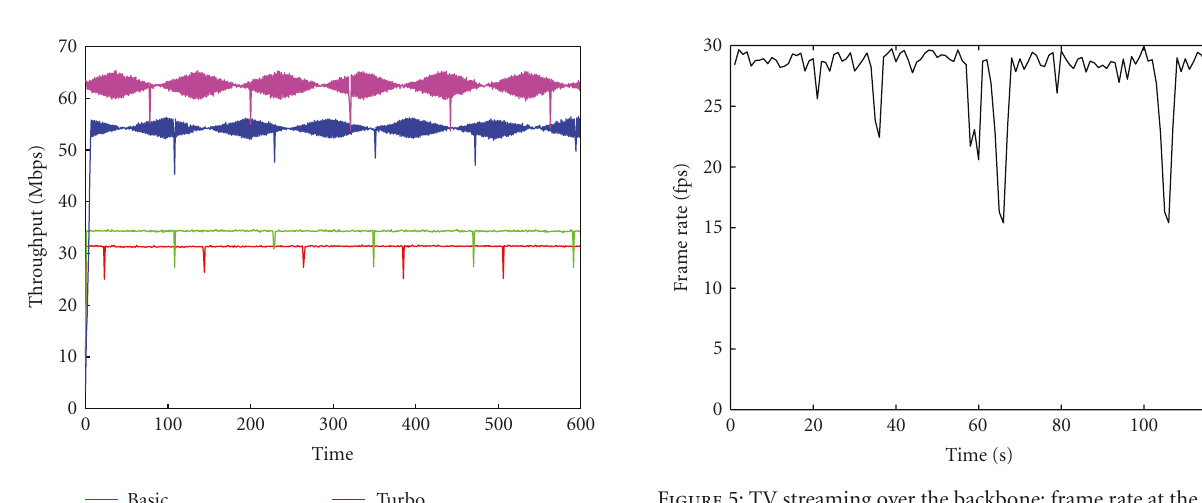
Figure 5: TV streaming over the backbone; frame rate at the